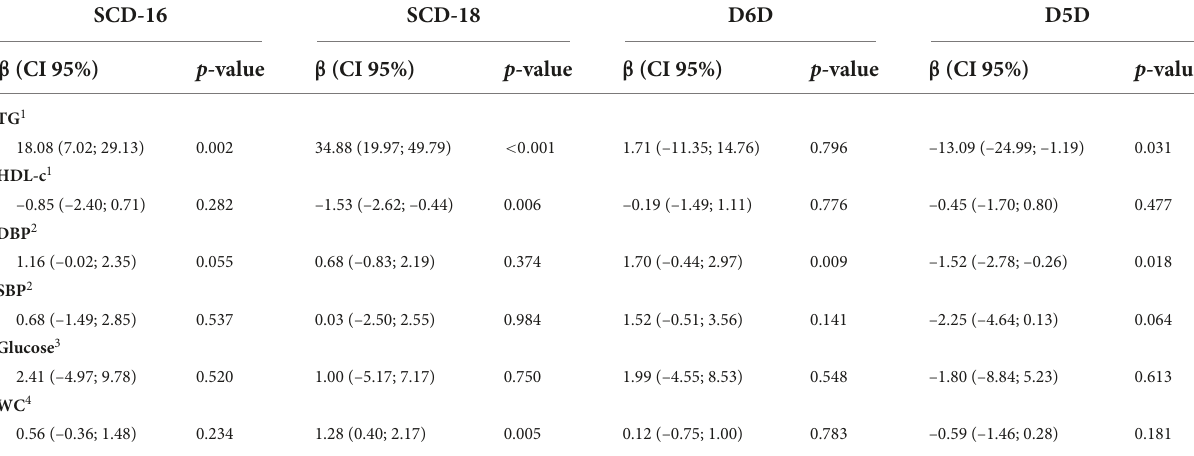
TABLE 6 Multivariable-adjusted regression for 1-year changes in estimated DEA per 1-SD increase and MetS components.